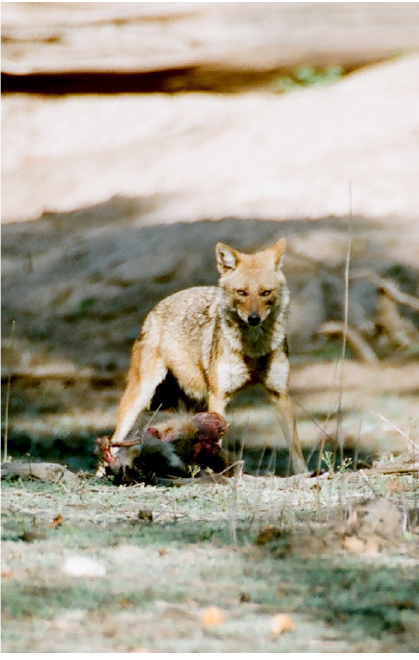
Image 2. Golden Jackal feeding on Hanuman Langur in Pench Tiger Reserve, Madhya